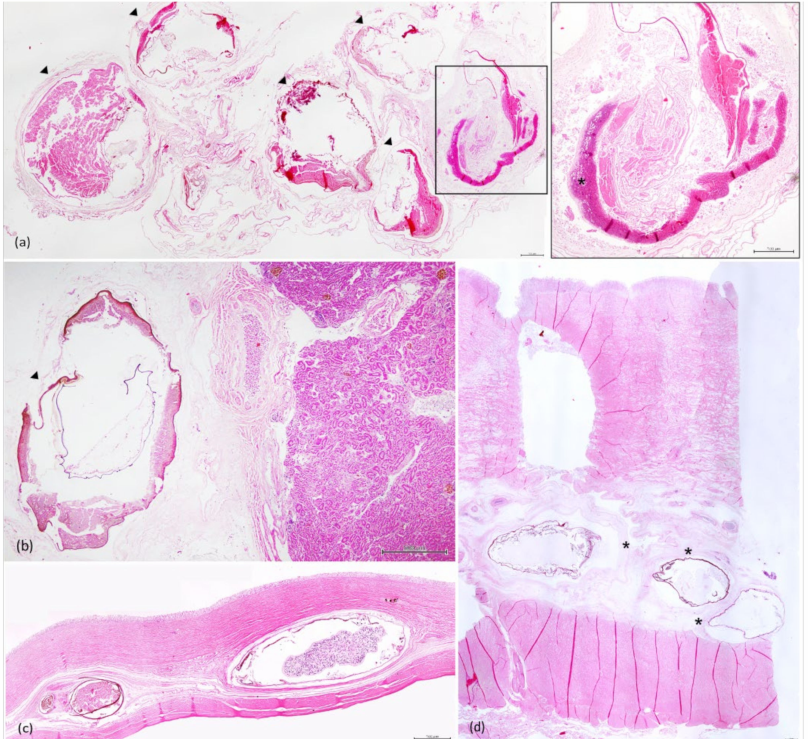
Figure 5. Histology, HE stain. ( a ) Peritoneum, cross-section of degenerated plerocerci (arrowheads) encapsulated in concentric layers of fibrous connective tissue (scale bar = 500 µ m). Inset: severe inflammatory infiltrate and cellular debris (*) surrounding a ruptured cyst (scale bar = 500 µ m). ( b ) Peritoneum, connective tissue adjacent to the kidney with a degenerated cyst (arrowhead) (scale bar = 500 µ m). ( c ) Intestine, viable ( right ) and degenerated plerocerci ( left ) admixed with golden- brown macrophage aggregates (MA) (scale bar = 500 µ m). ( d ) Stomach, numerous degenerated plerocerci embedded in a thick band of mature fibrous connective tissue (*) (scale bar = 500 µ